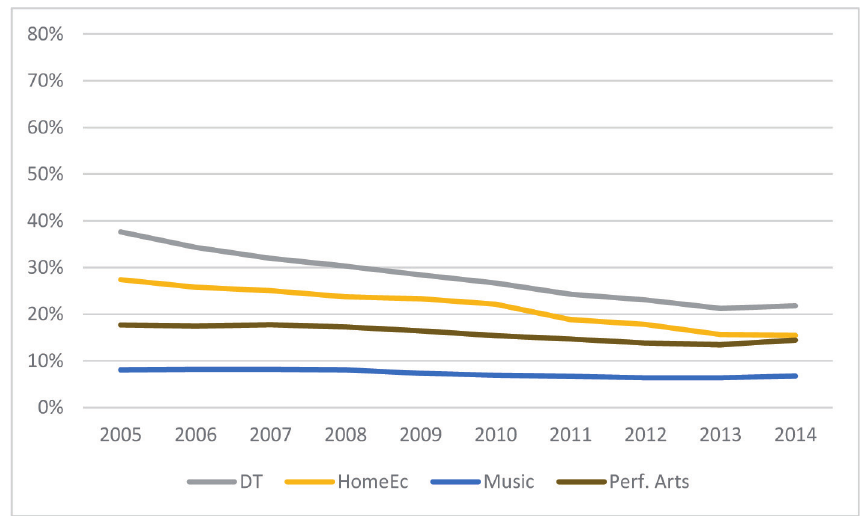
Figure 8: Percentage of pupils entered in GCSEs in design and technology, home economics, music, and performing arts 2005 to 2014